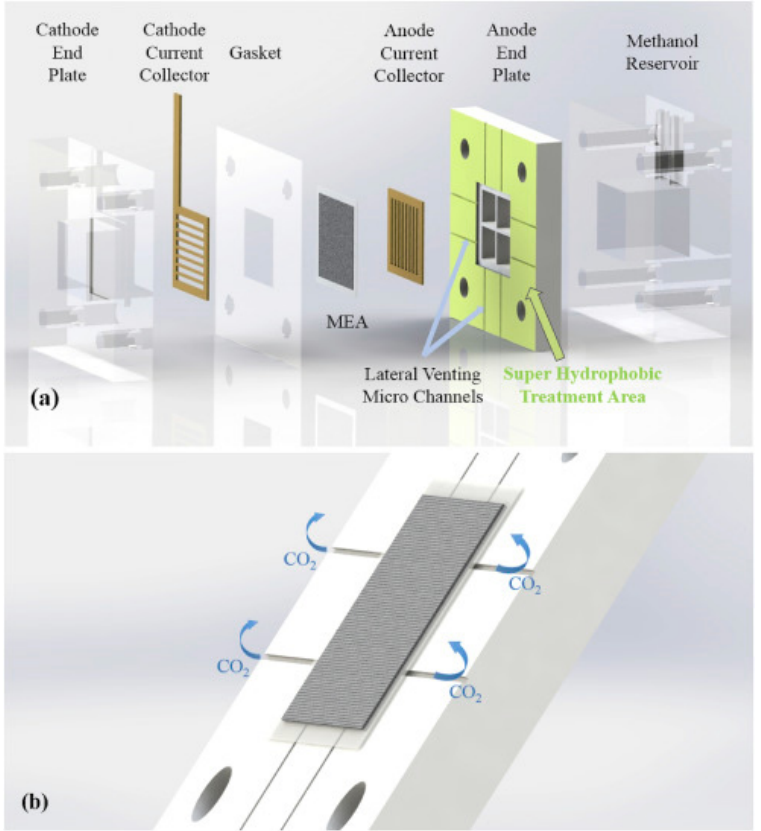
Figure 4. ( a ) Schematic configuration of PS-DMFCs with a super-hydrophobic lateral venting design of micro channels, and ( b ) detailed view of the six lateral venting micro channels. Reproduced from [100] with permission from Elsevier 2018.